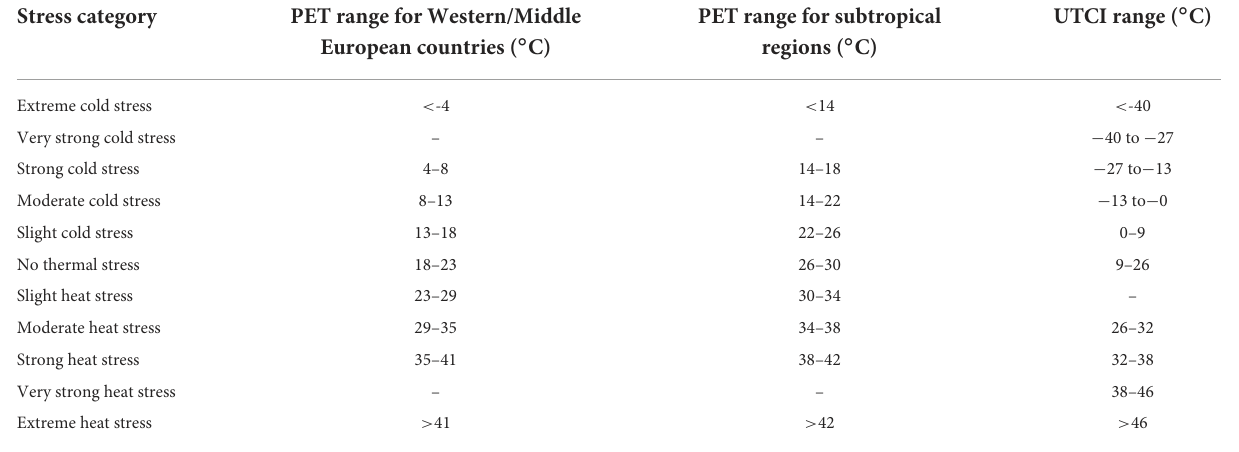
TABLE 1 Heat stress and thermal comfort indicators of PET and UTCI (47–49). Stress